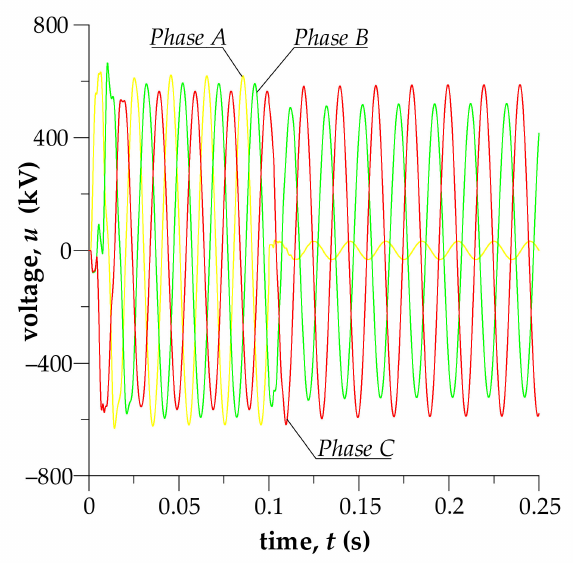
Figure 11. Transient phase voltages in the final discretisation node (18 km away from the line’s end) for the second